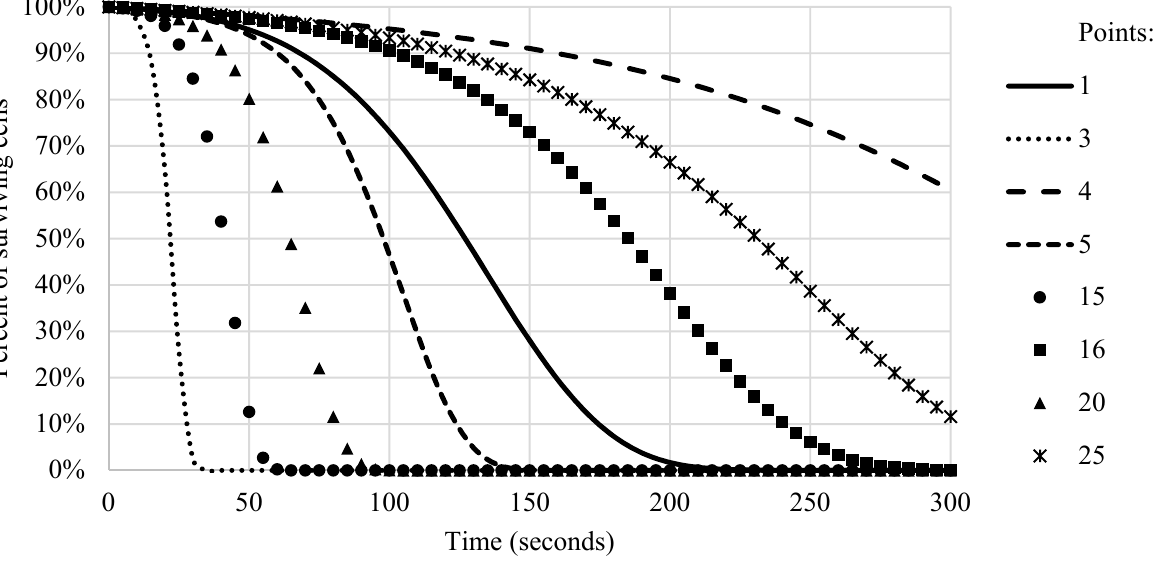
Figure 9. Percentage of undamaged cells for several locations identified in Figure 8 corresponding to Case 5 (30 W input power and a coolant mass flow rate of 1 g/s).